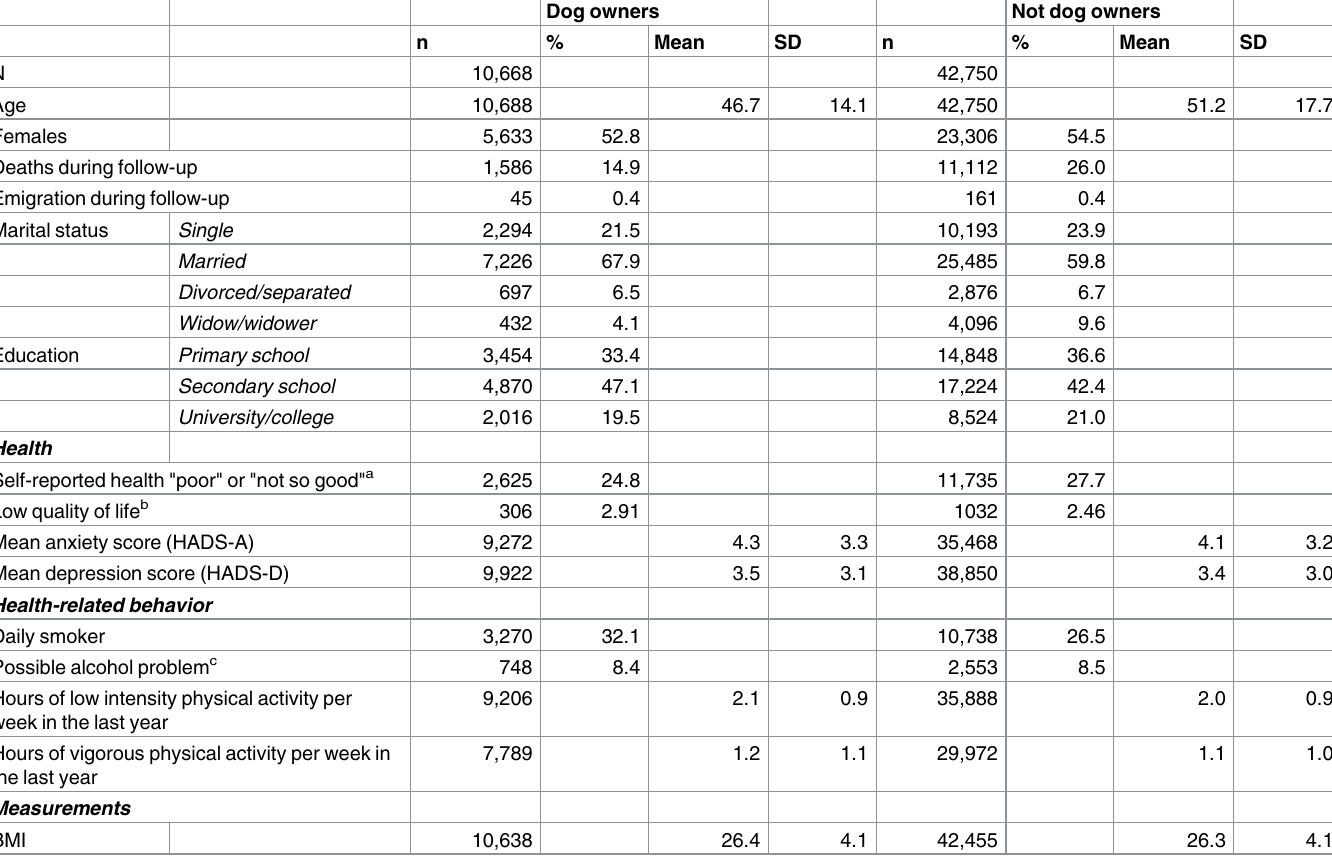
Table 1. Characteristics of the study